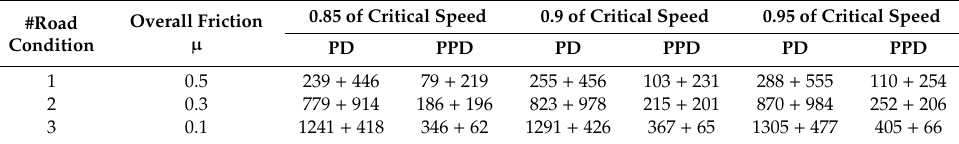
Table 8. Steering controllers target quality function for each parameter combination split by addends corresponding to deviation from the center of the lane and lateral acceleration, respectively.